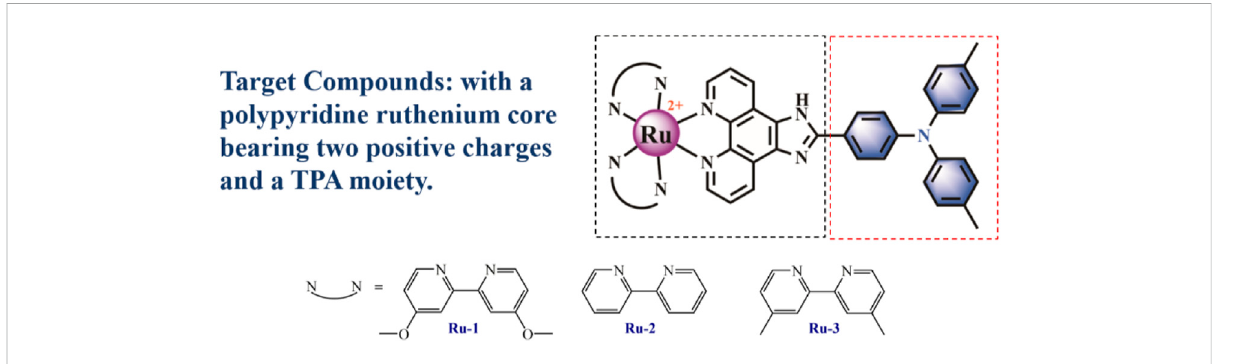
FIGURE 1 Structures and design stratege for target Ru(II)